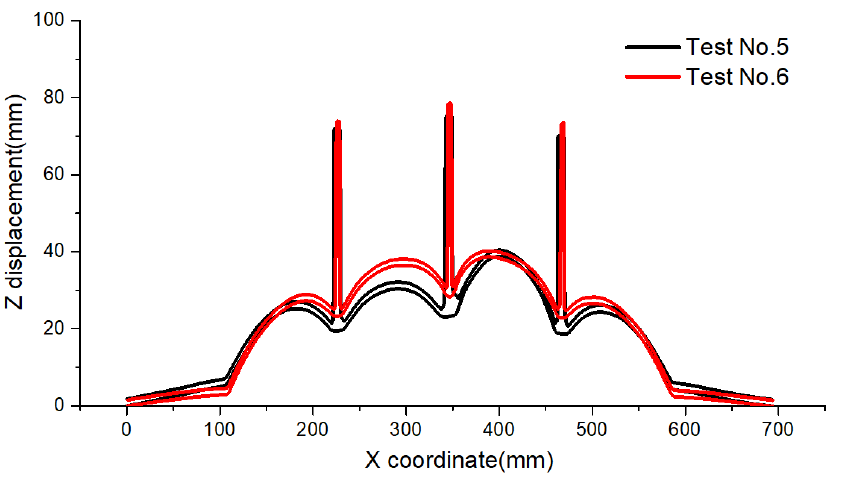
Figure 22. Central H-H section profile of Tests No. 5 and 6.